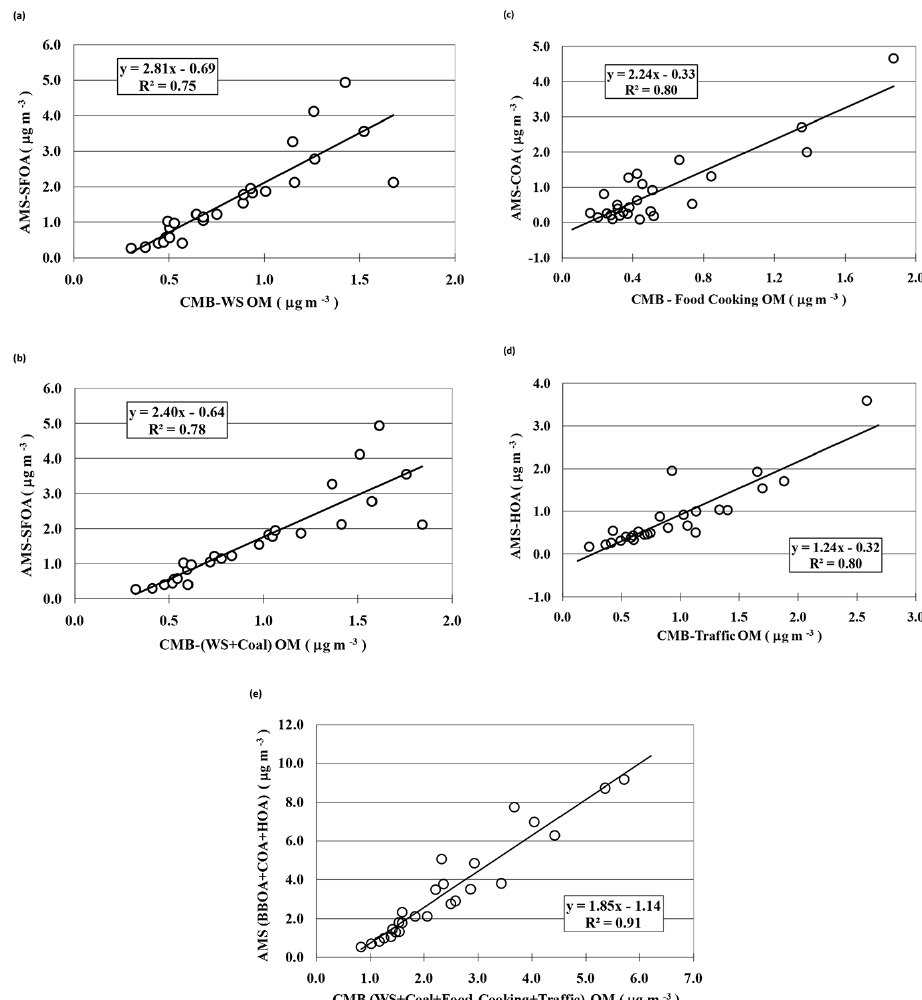
Figure 5. Primary component comparison between the AMS-PMF and CMB methods at